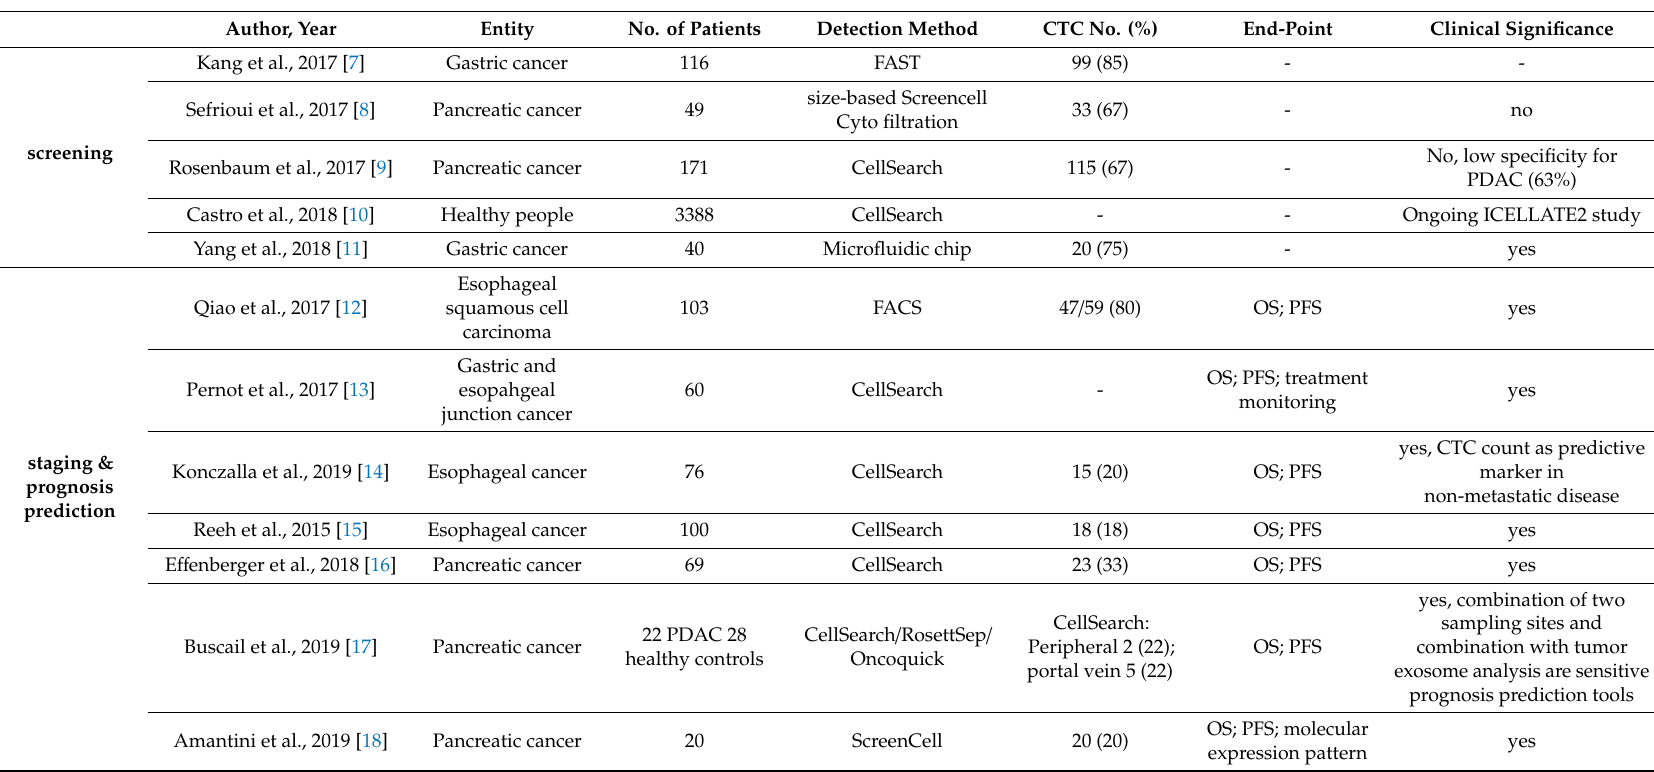
Table 1. Clinical significance of CTCs in gastrointestinal cancers as tools for screening, staging, prognosis prediction, therapy alignment and